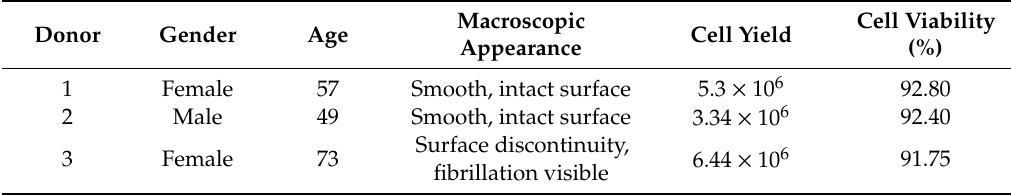
Table 1. Characterization of donor